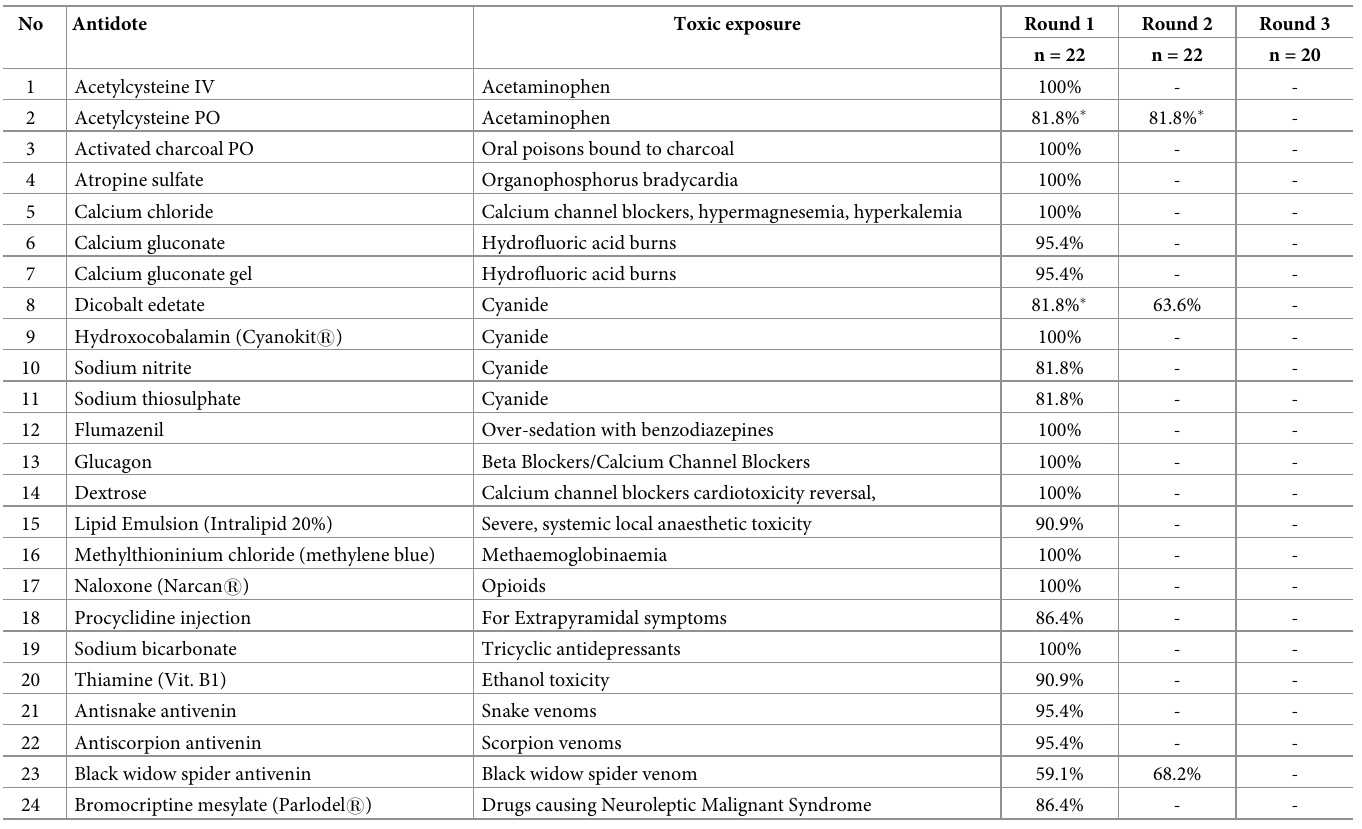
Table 2. Consensus level of each antidote in each Delphi